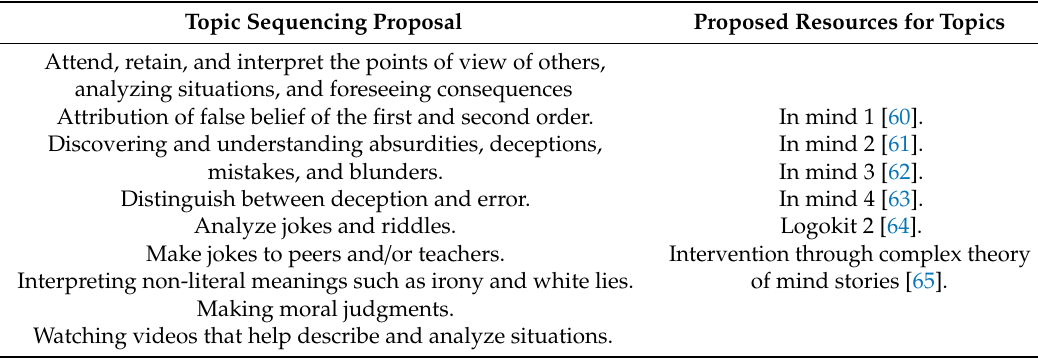
Table 3. Proposed sequencing of topics and